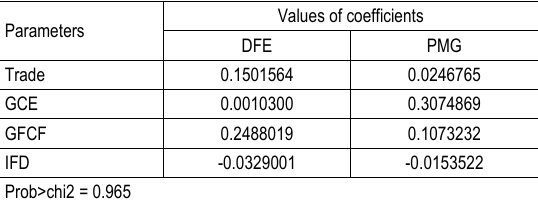
Table 13. The results of the Hausman test